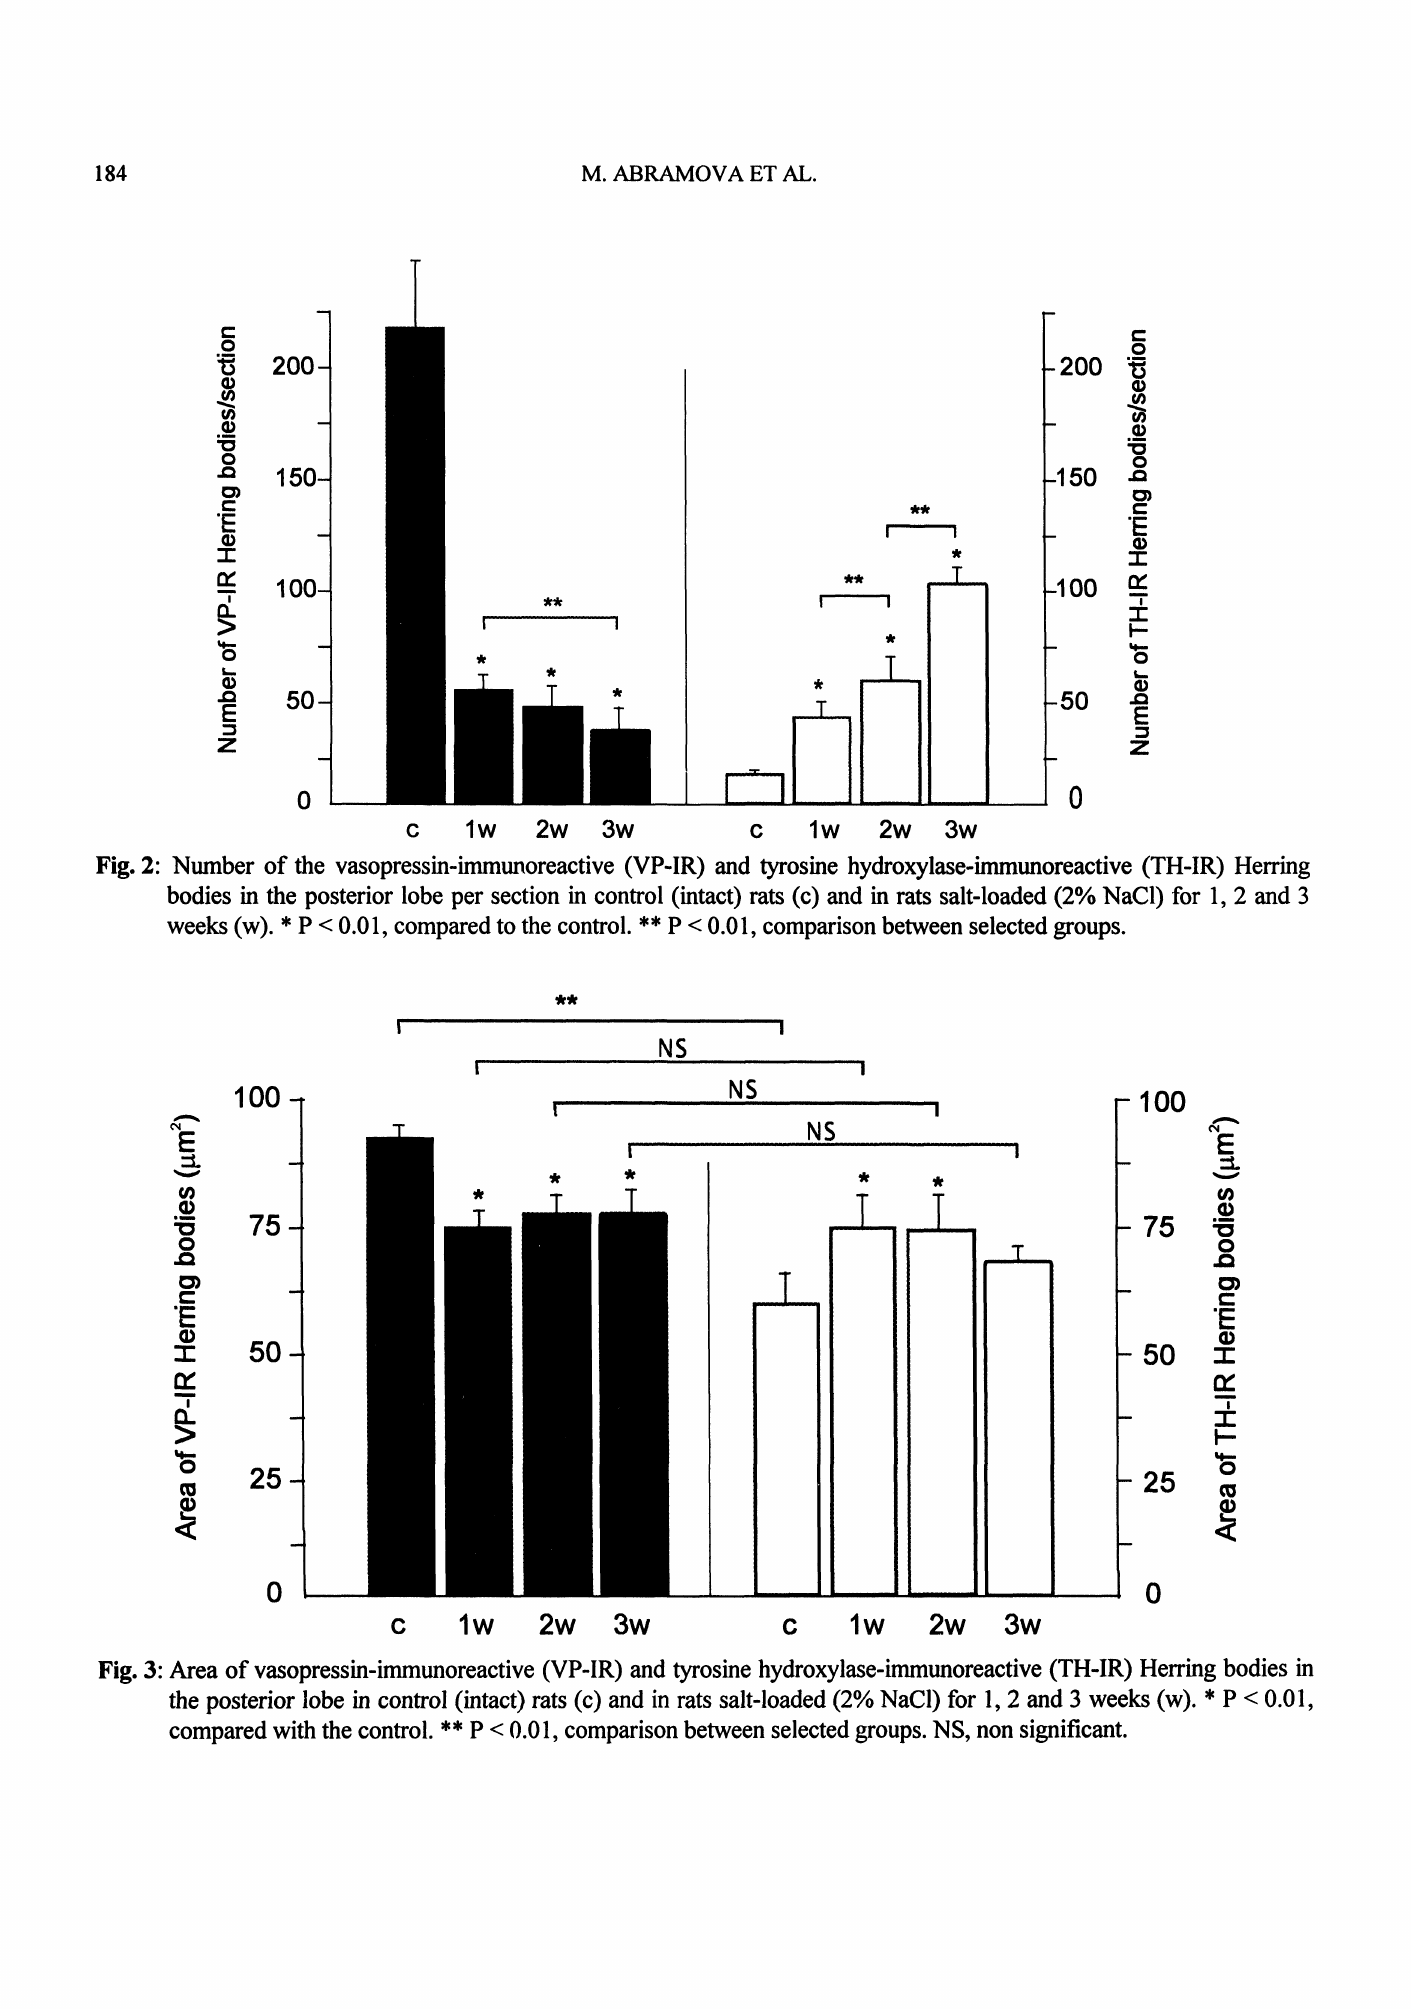
Fig. 3: Area of vasopressin-immunoreactive (VP-IR) and tyrosine hydroxylase-immunoreactive (TH-IR) Herring bodies in the posterior lobe in control (intact) rats (c) and in rats salt-loaded (2% NaCI) for 1, 2 and 3 weeks (w). * P < 0.01, compared with the control. ** P < 0.01, comparison between selected groups. NS, non